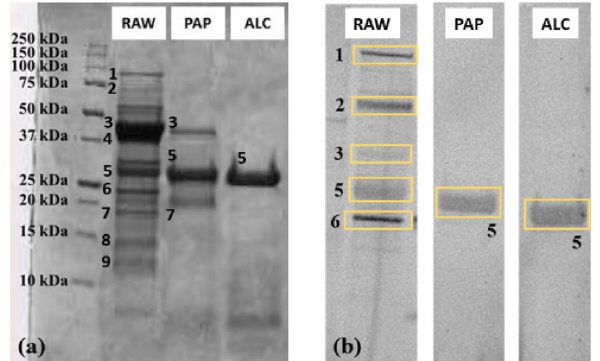
Figure 3. White bean SDS–PAGE gel ( a ) and immunoblot performed on serum H ( b ) on white bean by-product protein extract (RAW) and enzymatic hydrolysates with papain (PAP) and alcalase (ALC). Equal numbers indicate equal proteins. Original blots/gels are presented in Supplementary figures S2 for gel and S10 C for blot serum